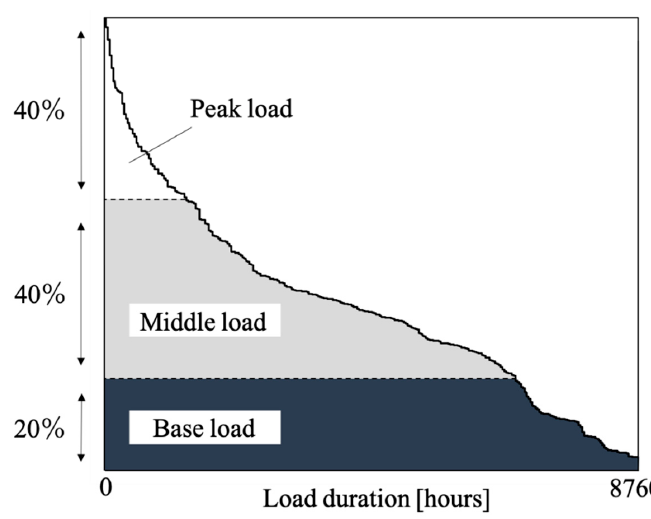
Figure 5. Heat load curve definition of the three categories.